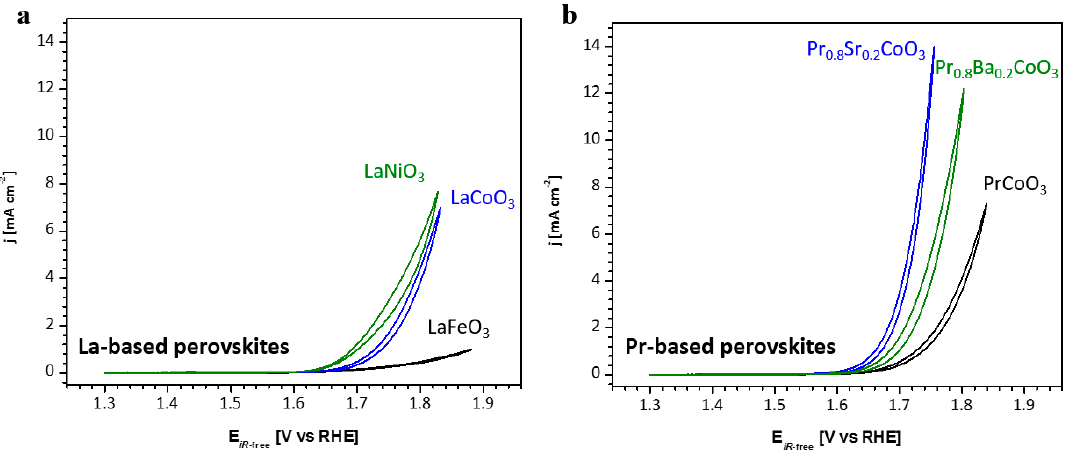
Figure 3. Oxygen evolution activities (cyclic voltammograms) of ( a ) La-based perovskites, and ( b ) Pr-based perovskites.